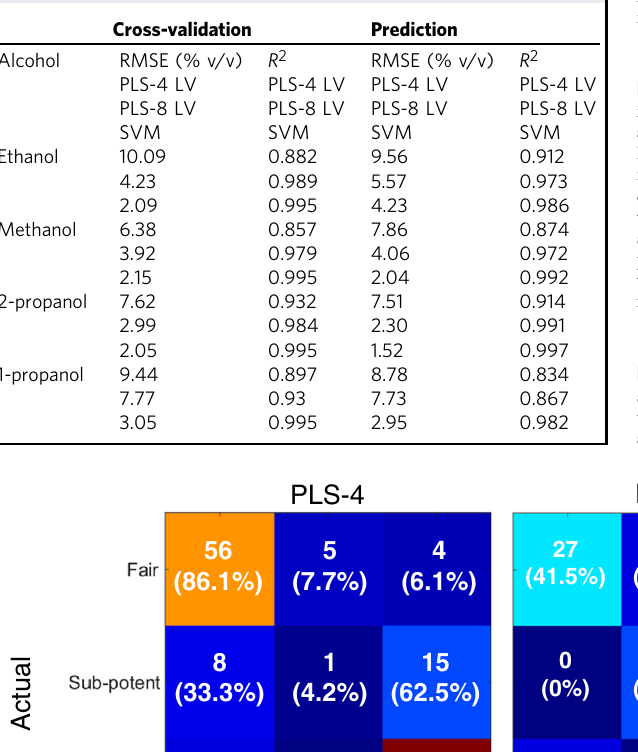
Table 1 RMSE and coef fi cient of determination ( R 2 ) of cross- validation and prediction for PLS models with four and eight latent variables, and